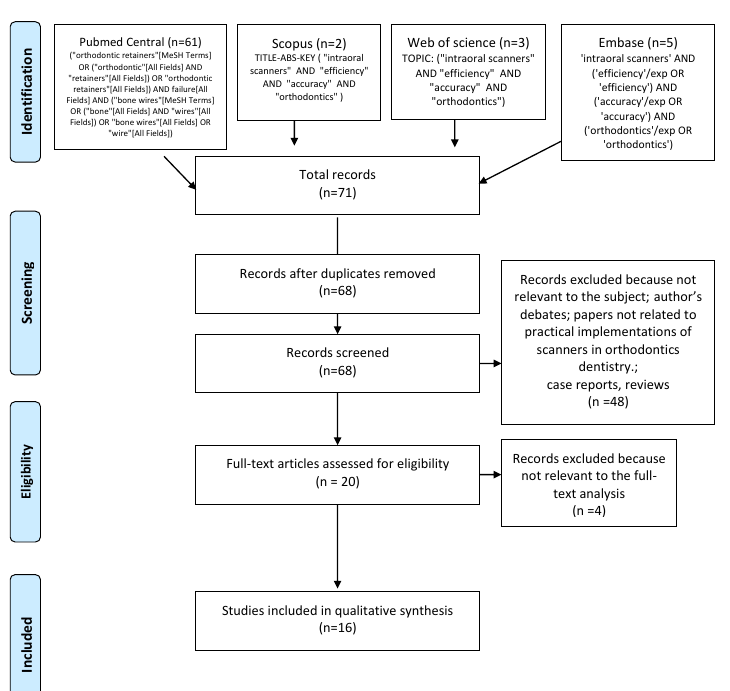
PRISMA 2009 Flow Diagram